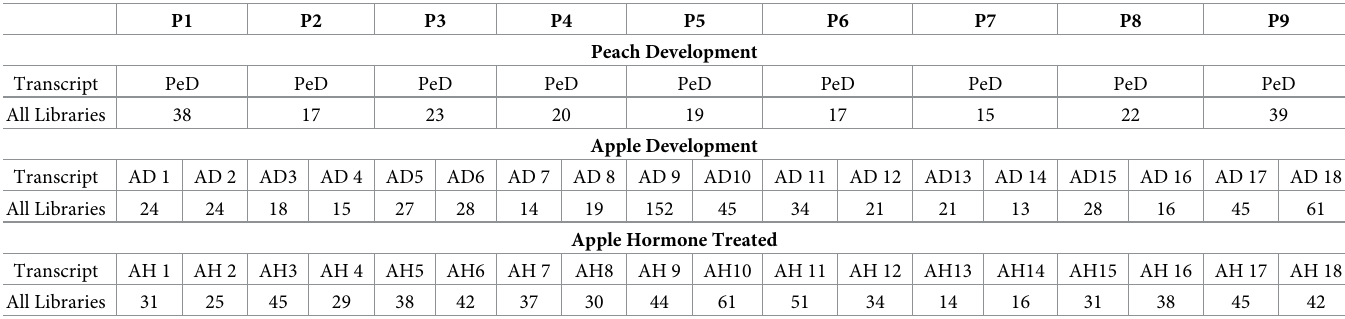
(DAA) to 18 DAA. The sample libraries were in triplicate. The second set was in apple and also looked at four different fruit tissues at four different stages from 0 DAA to 20 DAA. The sample libraries were in triplicate. The last set was also in apple and looked at the effects of two hormone treatments on three different fruit tissue at 18 DAA and at 132 DAA as well as a no pollination control and a hand pollinated control, all in triplicate samples [19]. The nine refer- ence genes identified in plum had already been compared to peach to identify orthologs. For Table 4. Overall coefficient of variance for RNAseq experiments in early Peach and Apple fruit for nine candidate reference genes.